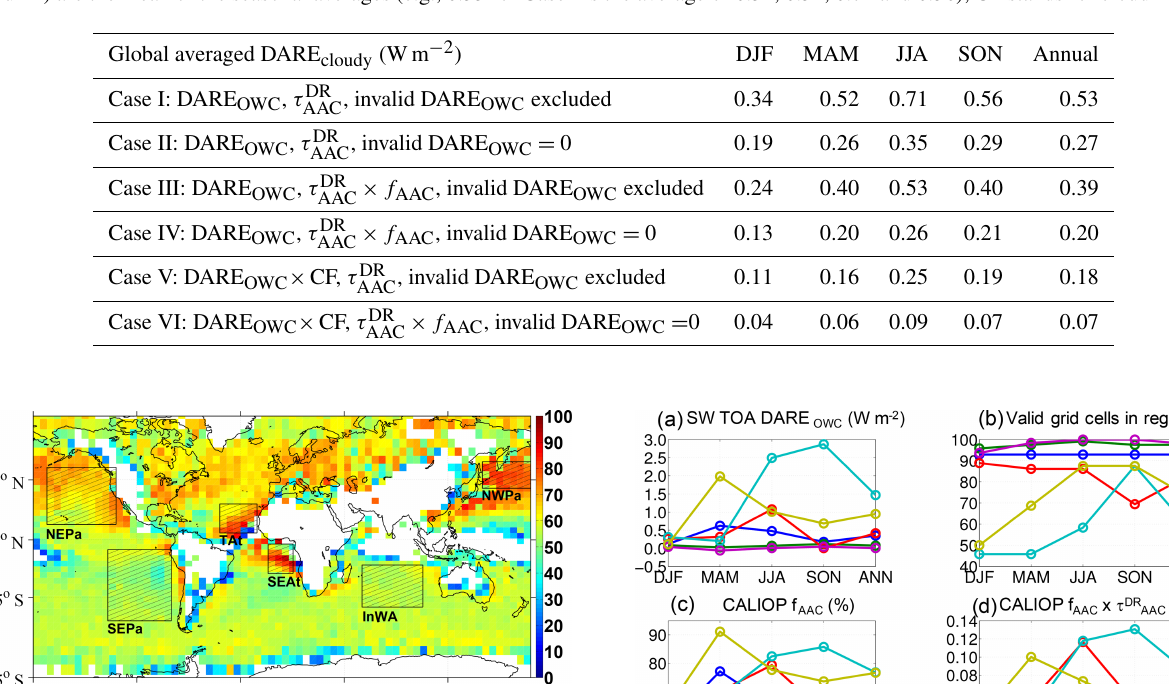
Table 4. Global seasonal and annual averages of TOA SW DARE OWC estimates (Wm − 2 , as described in Sect. 2.2). Annual averages (last column) are the mean of the seasonal averages (e.g., 0.53 for Case I is the average of 0.34, 0.52, 0.71 and 0.56); CF stands for cloud fraction.